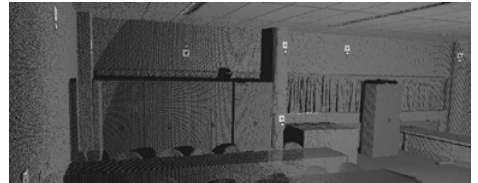
Figure 5. View of the acquired point cloud. Detail of the wall used for this study.